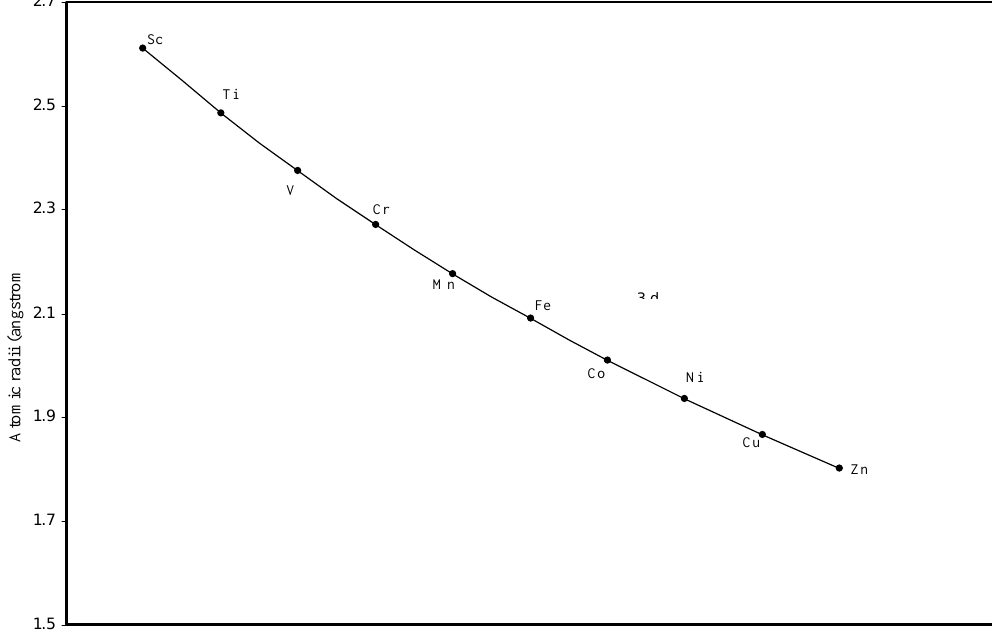
Figure 3. Plot of atomic radii of first transition sereis (3-d block) elements in angstrom unit as a function of atomic number.